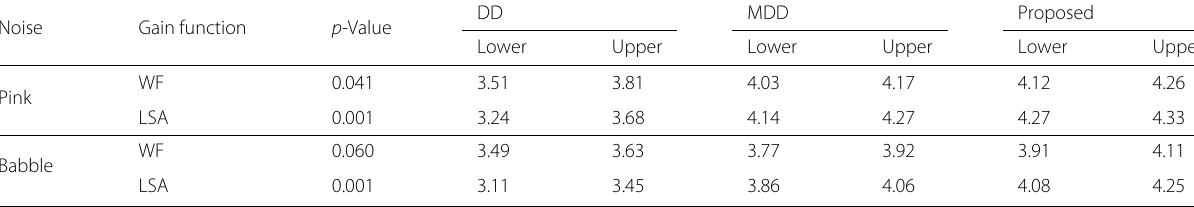
Table 13 Statistical analysis for subjective listening test under different noise conditions DD MDD Proposed Noise Gain function p -Value Lower Upper Lower Upper Lower Upper WF Pink Babble